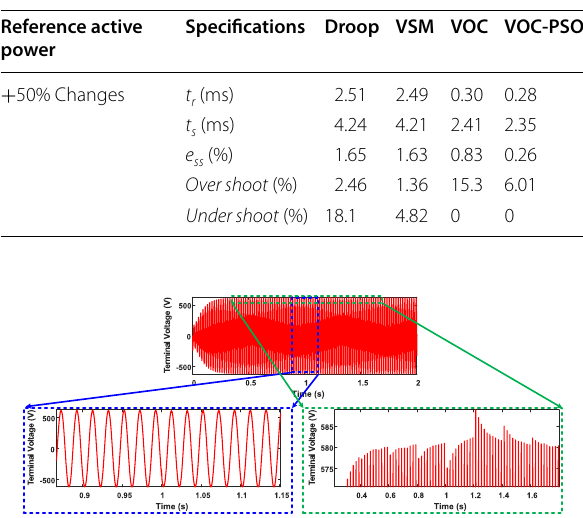
Fig. 18 Terminal voltage of the VOC controlled inverter (R-Phase) with changing the load from 25 to 200%